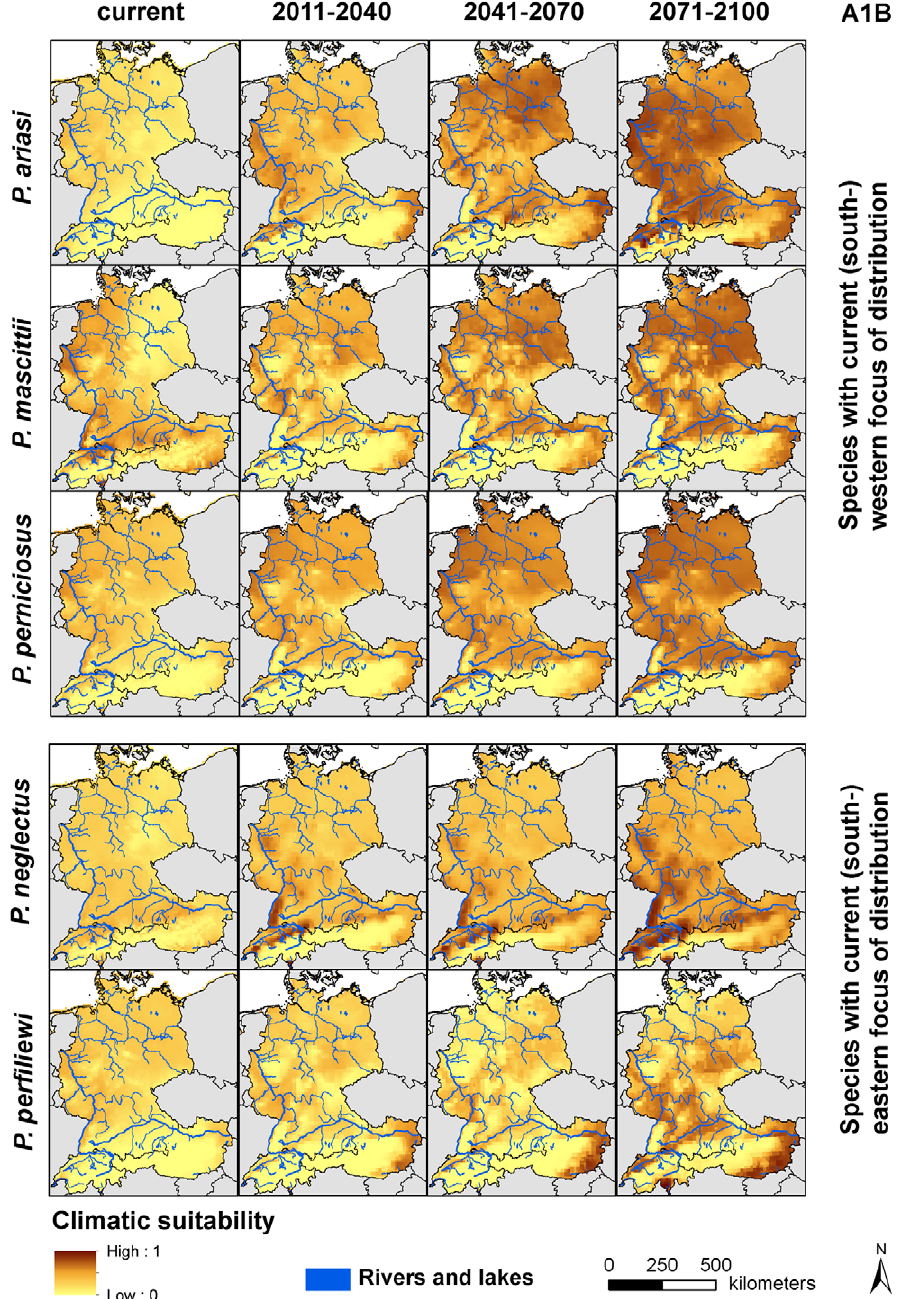
Figure 3. Current and projected climatic suitability for five Phlebotomus species. Values of climatic suitability range theoretically from 0 (unfavourable conditions) to 1 (perfect conditions). Projections refer to the A1B